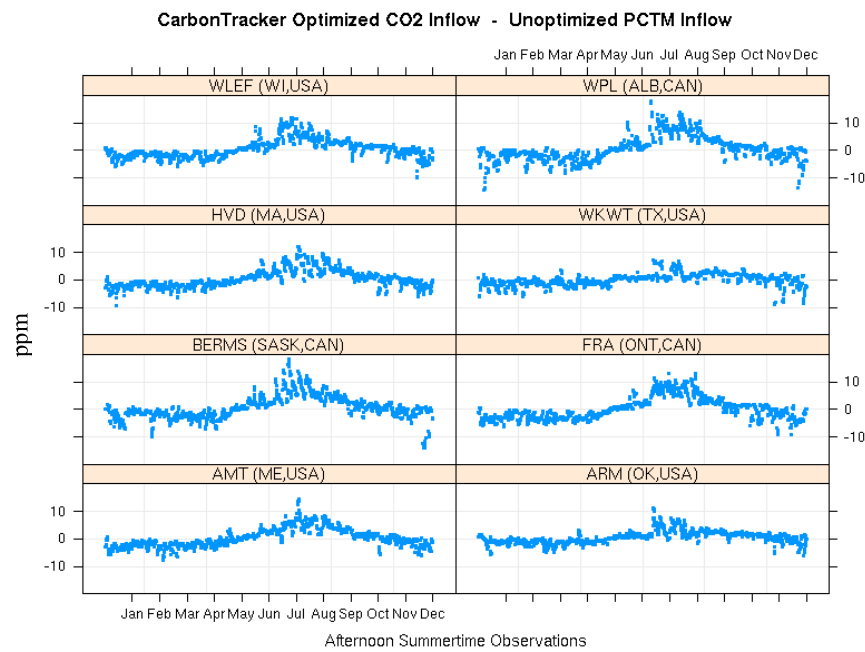
Figure 6: Figure shows the effect of boundary inflow CO 2 upon tower CO 2 concentrations. In particular, this figure shows the “difference” between estimates of CO 2 arriving at tower due to two distinct boundary inflows (1420 sequential “12/2/4/6p.m.” observation sequences for each of 8 towers.)